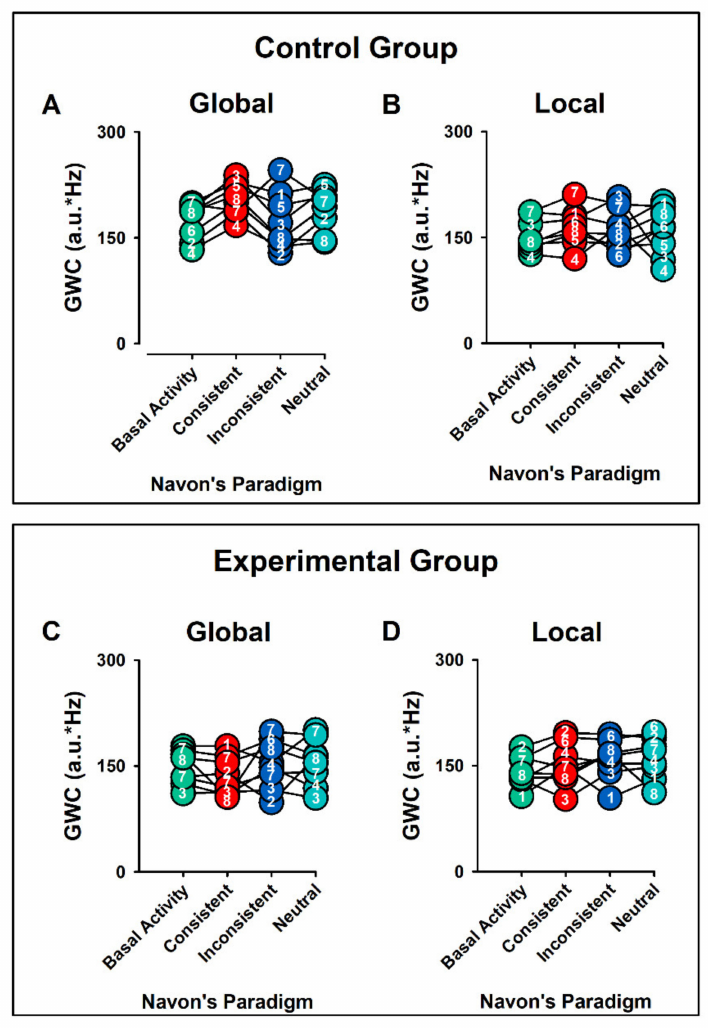
Figure 2. Pooled data for Global Mean-Weighted Coherence (GMWC), during Global ( A , C ) and Local ( B , D ) Aspect Recognition Test, for the control and experimental group, respectively. The individual values for each subject are represented with a number. In each case, the basal EEG activity, consistent, inconsistent, and neutral conditions are displayed. Note the interindividual differences. We observed higher values of GMWC in consistent and inconsistent Global Aspect Recognition in control group in comparison with ADHD group. Arbitrary units = a.u.; * = multiplication